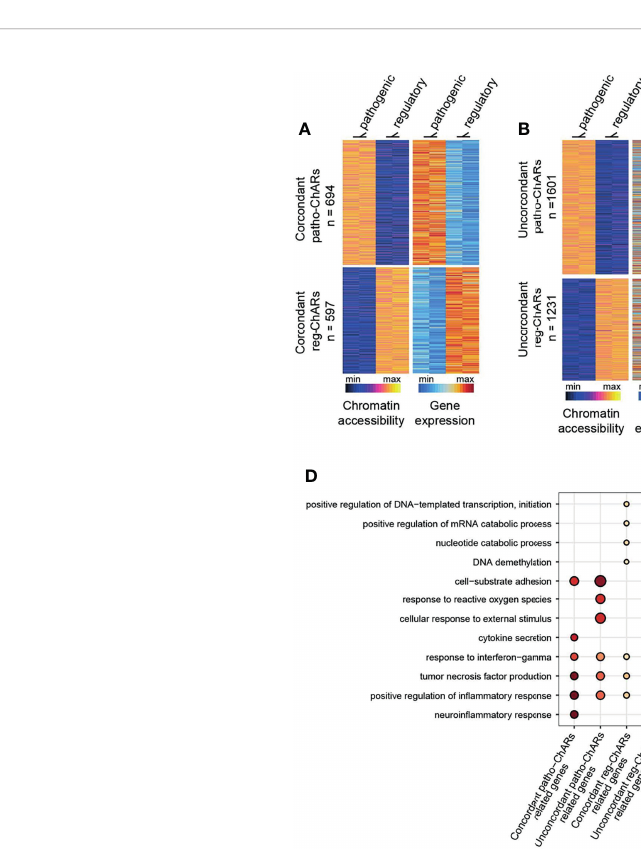
FIGURE 2 | Expression concordant patho-ChARs associate with Th17 to Th1 conversion. (A) Heatmap of expression concordant ChARs in pathogenic and regulatory Th17 (left), and their related gene expression (right). (B) Heatmap of expression unconcordant ChARs (left) and their related gene expression (right). (C) Distance of concordant patho-ChARs and concordant reg-ChARs to their neighboring TSSs. Percentage of ChARs found within +1 to -1 Kb of TSS were calculated. (D) GO enrichment of concordant patho-ChARs, concordant reg-ChARs, unconcordant patho-ChARs, and unconcordant reg-ChARs. (E) Similarity between pathogenic Th17, regulatory Th17 and pro-in fl ammatory Th1 in accessibility to concordant patho-ChARs and reg-ChARs. (F) Similarity between pathogenic Th17, regulatory Th17 and pro-in fl ammatory Th1 in accessibility to unconcordant patho-ChARs and